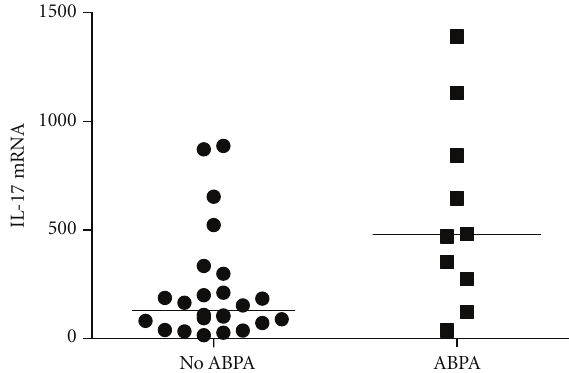
F 2: Sputum IL-17A mRNA levels in CF patients without and with ABPA. Sputum mRNA was extracted from adult CF patients without ( ) and with ( ) ABPA and IL-17A mRNA levels were measured by real-time RT-PCR [44]. ABPA was de�ned on the basis of (1) deteriorating lung function, (2) immediate 𝑛𝑛 𝑛 𝑛𝑛 𝑛𝑛 𝑛 𝑛 Aspergillus fumigatus ( ) skin test reactivity, (3) serum total IgE speci�c IgE and IgG antibodies, and (5) chest radiographic 𝑎𝑎𝑎𝑎 > 𝑎𝑎𝑎𝑎